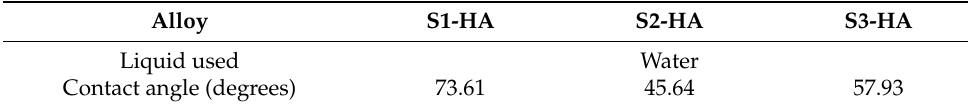
Table 6. Water contact angle values on the surface of alloys studied.